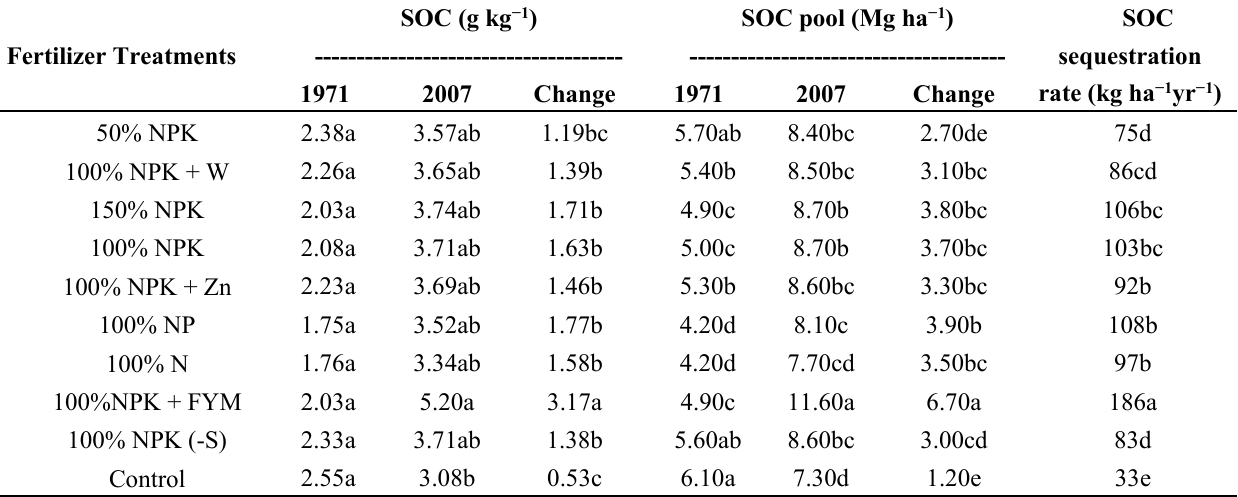
Table 2. Changes in soil organic carbon (SOC), SOC pool and carbon sequestration rate after 36 years of different fertilizer applications in maize–wheat rotation. Fertilizer